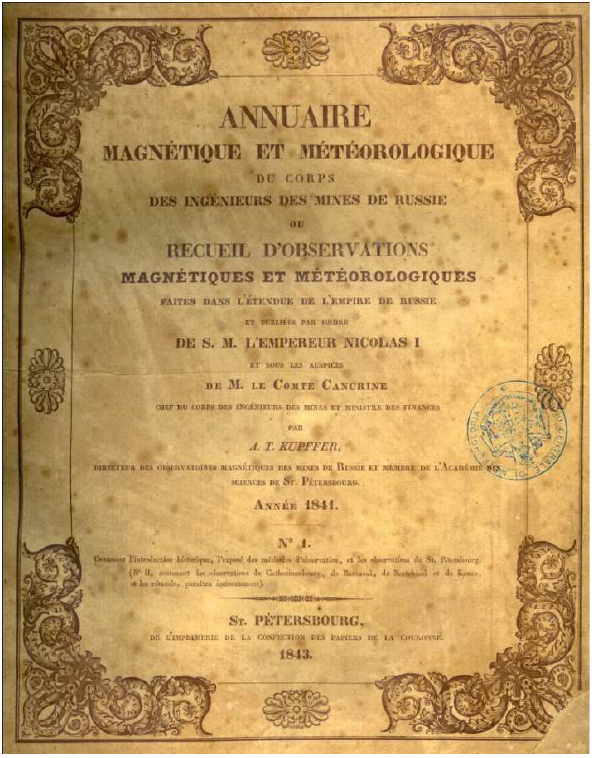
Fig. 7 Figure 7. Magnetic and Meteorological Yearbook, St. Petersburg,